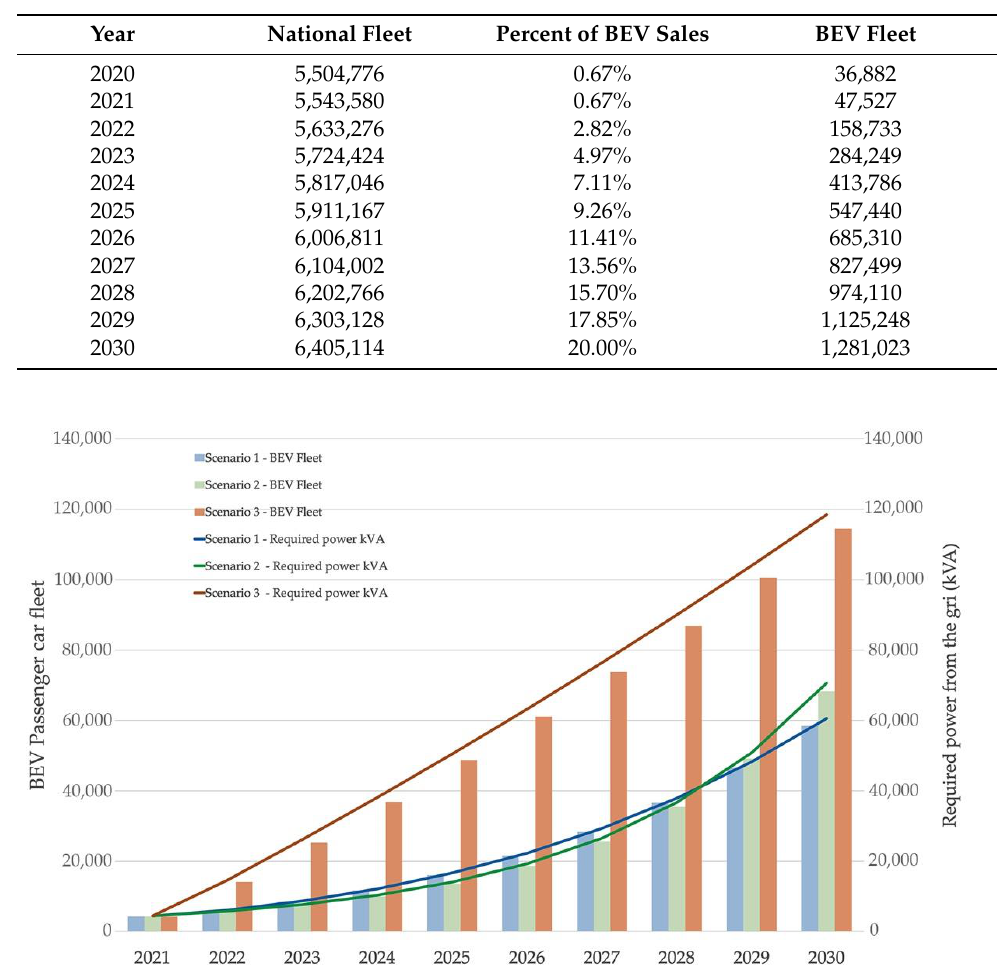
Table 7. Calculation of the BEV fleet in scenario 1.